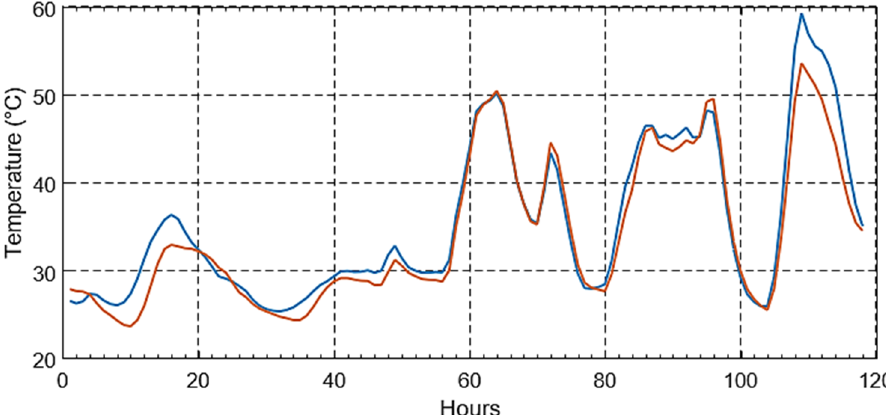
Figure 43. Hot-spot temperature through simulated (blue) and measured (orange) ambient temperature for January.